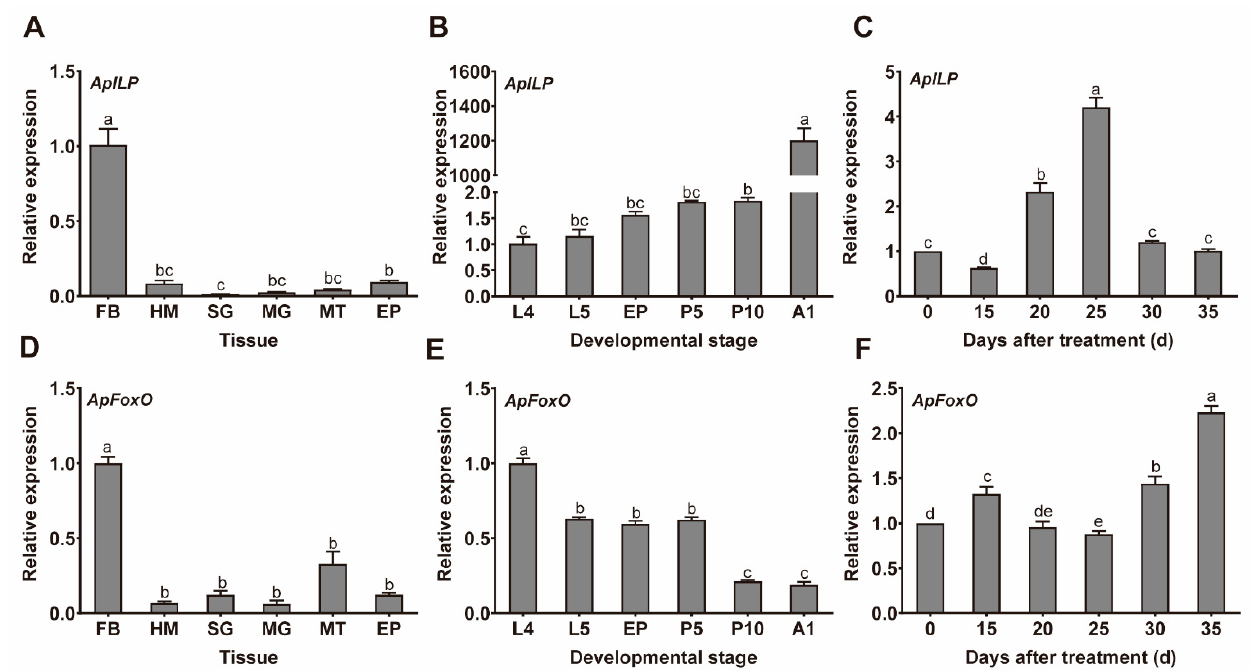
Figure 1. Temporal and spatial expression patterns of ApILP and ApFoxO in Antheraea pernyi . ( A , D ) Relative expression levels of ApILP and ApFoxO , respectively, in different tissues of fifth-instar larvae; abbreviations: fat body (FB); hemocyte (HM); silk gland (SG); midgut (MG); Malpighian tubules (MT); epidermis (EP). ( B , E ) Expression profiles of ApILP and ApFoxO , respectively, at different developmental stages; abbreviations: 4th- and 5th-instar larvae (L4 and L5, respectively); early pupae (EP); 5-day-old and 10-day old pupae (P5 and P10, respectively); 1-day-old adults (A1). ( C , F ) Changes in the relative expression levels of ApILP and ApFoxO , respectively, after diapausing pupae were subjected to long-day photoperiod (L:D 17:7) treatment to break diapause. Based on the transparency of the epicranium, treated pupae were collected for qRT-PCR analysis on indicated days (15, 20, 25, 30, and 35 d) after long-day photoperiod (L:D 17:7) treatment. Diapausing pupae (day 0) were used as a control group. The period of the long-day photoperiod treatment incorporated two phases: the diapause termination phase (which continued until day 20 of treatment), and the post-termination phase (which started on day 25 and ended on day 35 of treatment). The mRNA levels were normalised to the reference genes actin and RP49 . Data represent the means of three independent experiments, and error bars are SEs. Different letters above the error bars indicate significant differences at p <